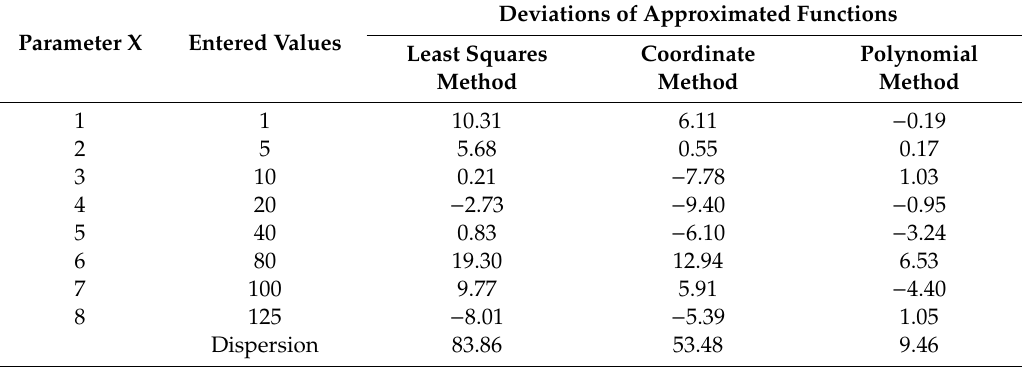
Figure 8. Comparison of the basic level of maintenance labor intensity, calculated by various approximation methods. Source: authors. Table 1. Evaluation of the approximation of technical level of machines.